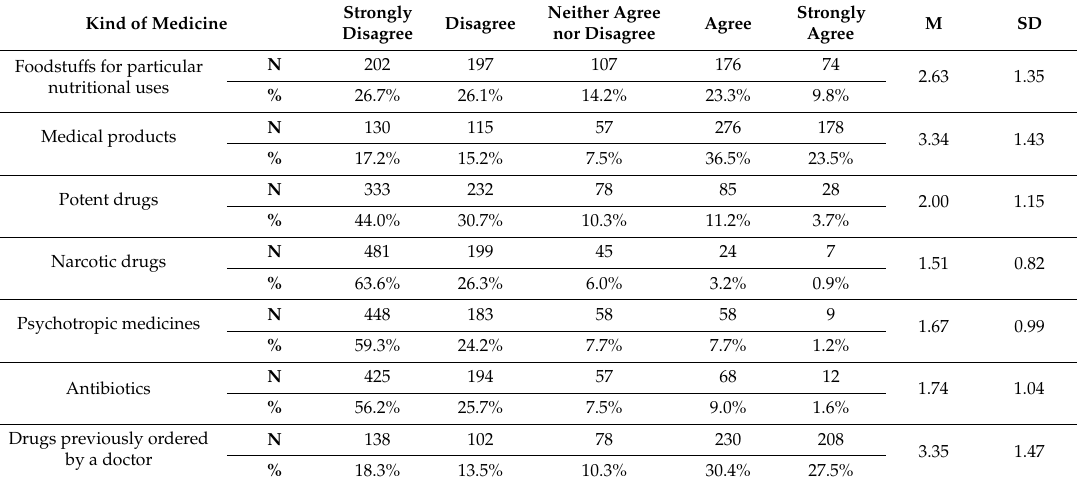
Table 1. Nurses’ self-assessed preparedness for prescribing